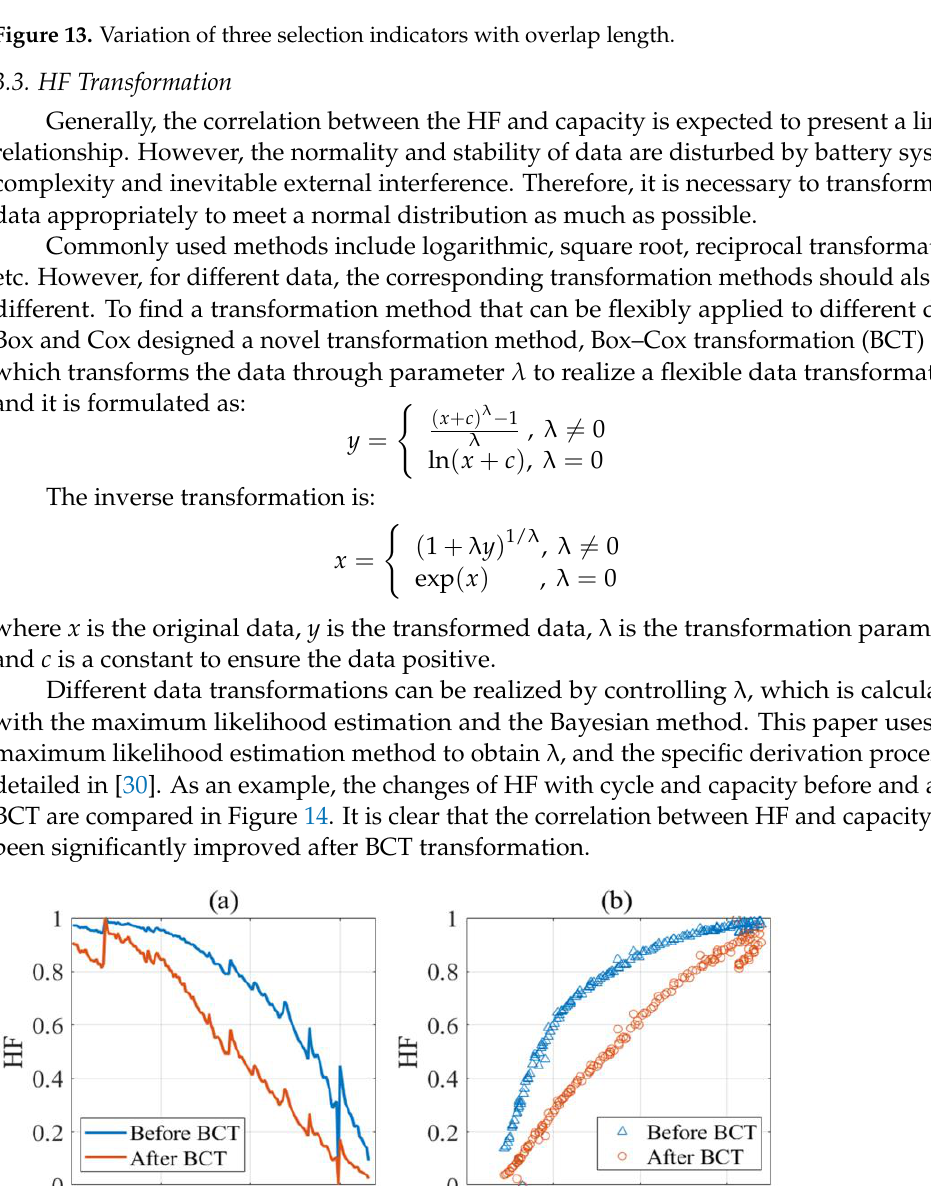
Figure 13. Variation of three selection indicators with overlap length.